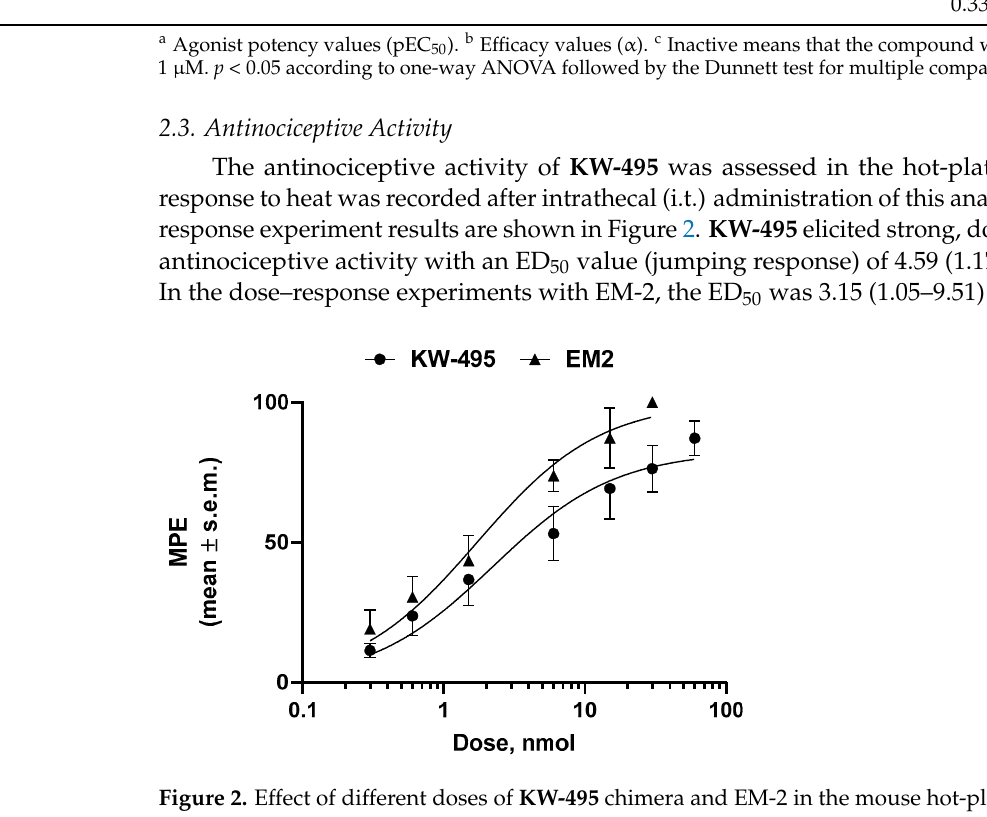
a Agonist potency values (pEC b Efficacy values ( α ). c Inactive means that the compound was inactive up to 50 ). 1 µ M. p < 0.05 according to one-way ANOVA followed by the Dunnett test for multiple comparisons.